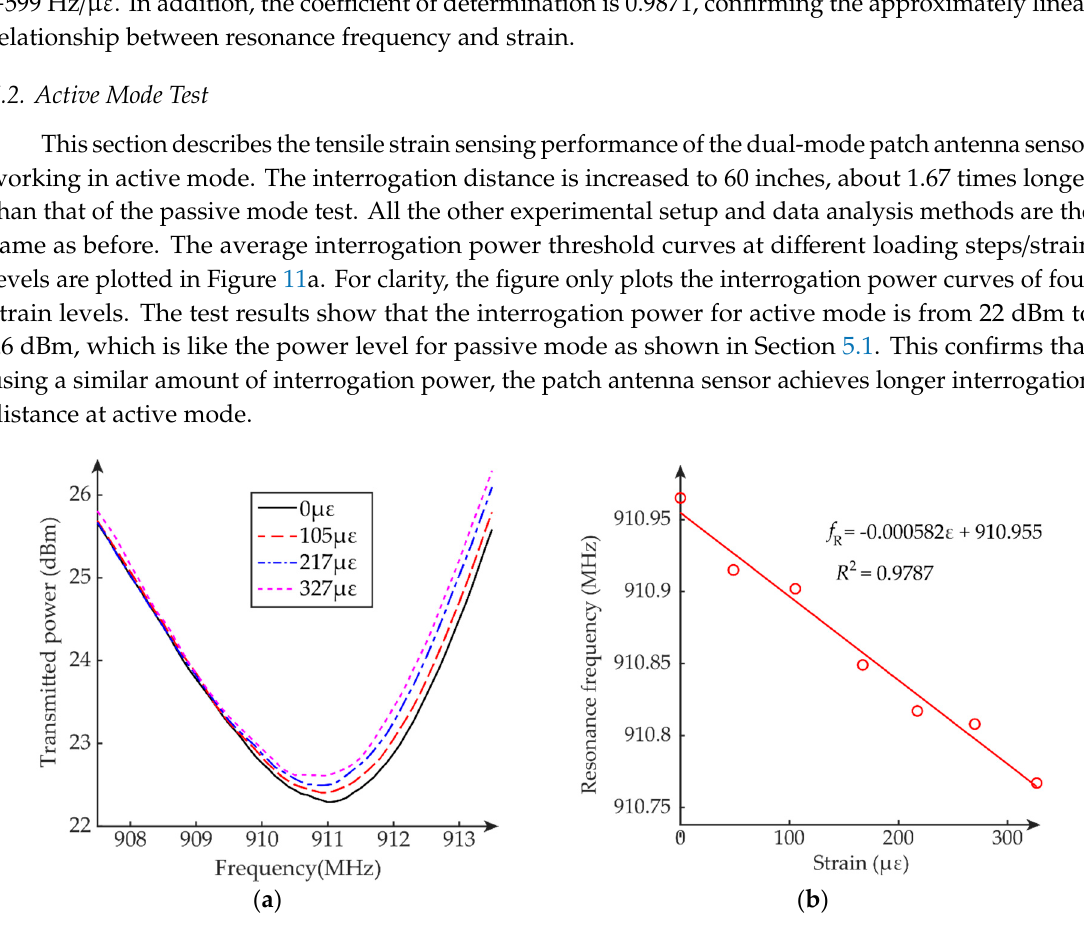
Figure 11. Tensile test results of active mode test: ( a ) average interrogation power threshold, ( b ) resonance frequency f R versus strain ε